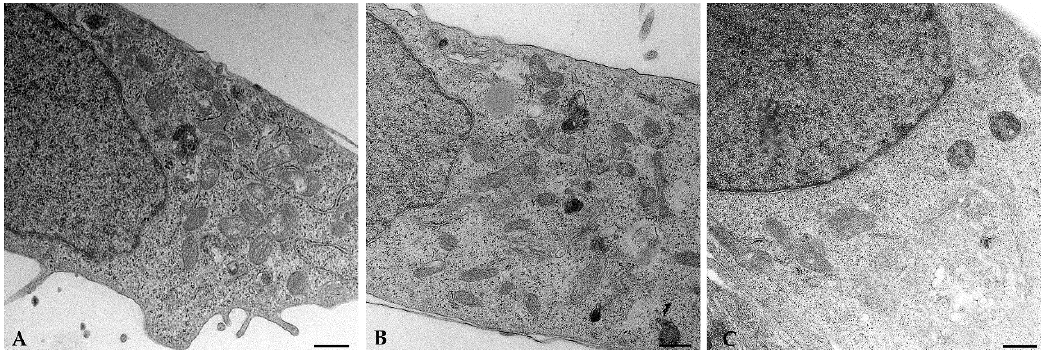
Figure 4. Representative transmission electron microscopy (TEM) images of untreated ( A ), 24 h BCA- ( B ) or caffeine-treated hGL5 ( C ). Mitochondria of cells treated with BCA are elongated and tubular when compared to the round mitochondria found in control cells, whereas mitochondria of cells treated with caffeine are smaller and rounded. Scale bar: A and C, 500 nm; B, 200 nm. Image representative of three independent experiments.